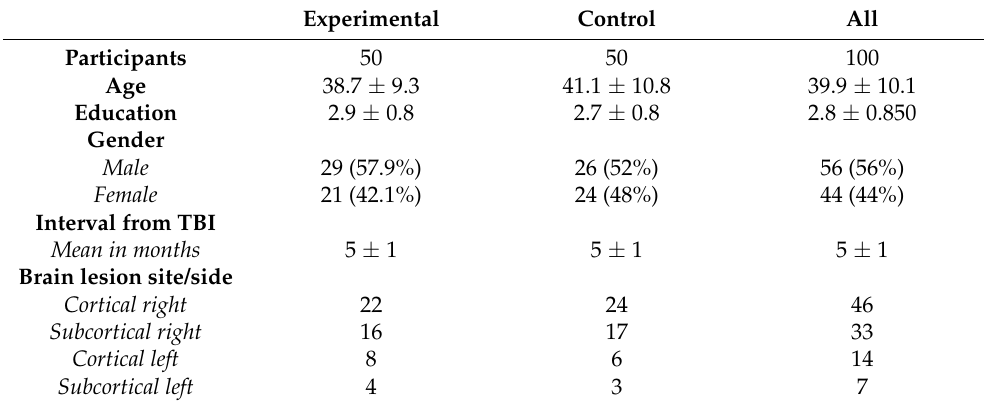
Table 1. Demographics characteristics at baseline for both groups. Quantitative variables were expressed as means ± standard deviations, and categorical variables as frequencies and percentages. Experimental Control All Participants 50 50 100 Age 38.7 ± 9.3 41.1 ± 10.8 39.9 ± 10.1 Education 2.9 ± 0.8 2.7 ± 0.8 2.8 ± 0.850 Gender Male 29 (57.9%) 26 (52%) 56 (56%) Female 21 (42.1%) 24 (48%) 44 (44%) Interval from TBI Mean in months 5 ± 1 5 ± 1 5 ± 1 Brain lesion site/side Cortical right 22 24 46 Subcortical right 16 17 33 Cortical left 8 6 14 Subcortical left 4 3 7